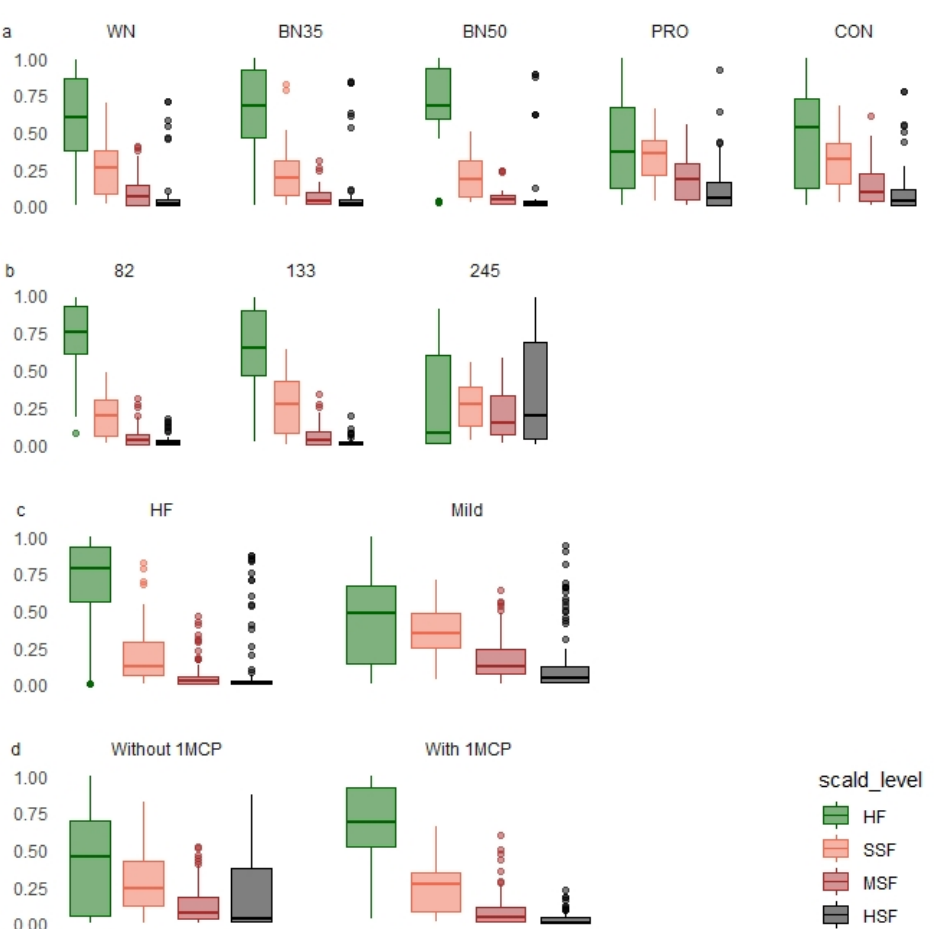
Figure 10. Proportion of fruits at each level of scald (HF healthy fruit, SSF = slightly scalded fruit, MSF = moderately scalded fruit, HSF = heavily scalded fruit) for season 3, according to: ( a ). field treatment (BN35 = Black net 35, BN50 = Black net 50, WN = White net, CON = control and PRO = protectants), ( b ). days of storage, ( c ). sun damage at harvest (HF healthy fruit, SIS light sunburn), and ( d ). post-harvest treatment (without 1-MCP or with 1-MCP). The box represents interquartile range (IQR); the upper (Q3) and lower (Q1) quartiles are the ends. The line in the box is the median and the whiskers are the rang of the data, excluding outliers. Outliers are values higher than Q3 + 1.5 IQR or smaller than Q1 − 1.5 IQR.